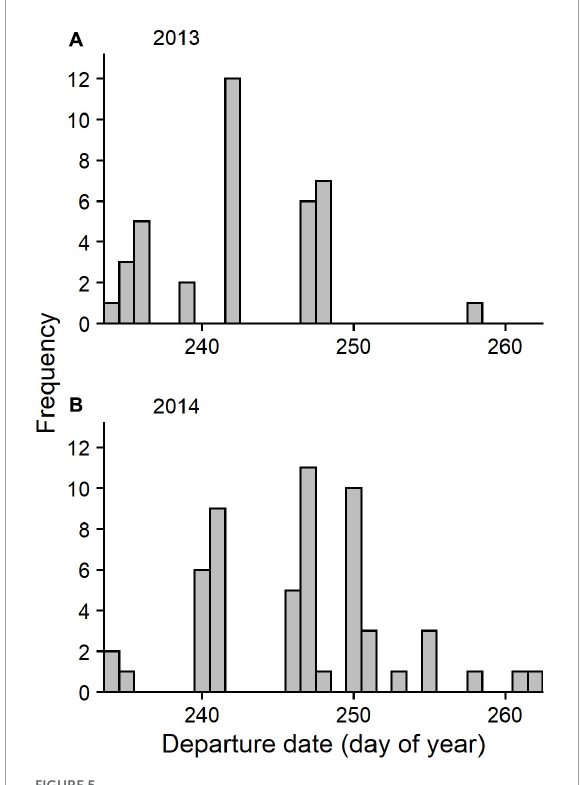
FIGURE5 Frequency of departures by tagged Semipalmated Sandpipers from the Bay of Fundy on each day of the fall staging period in (A) 2013 and (B)